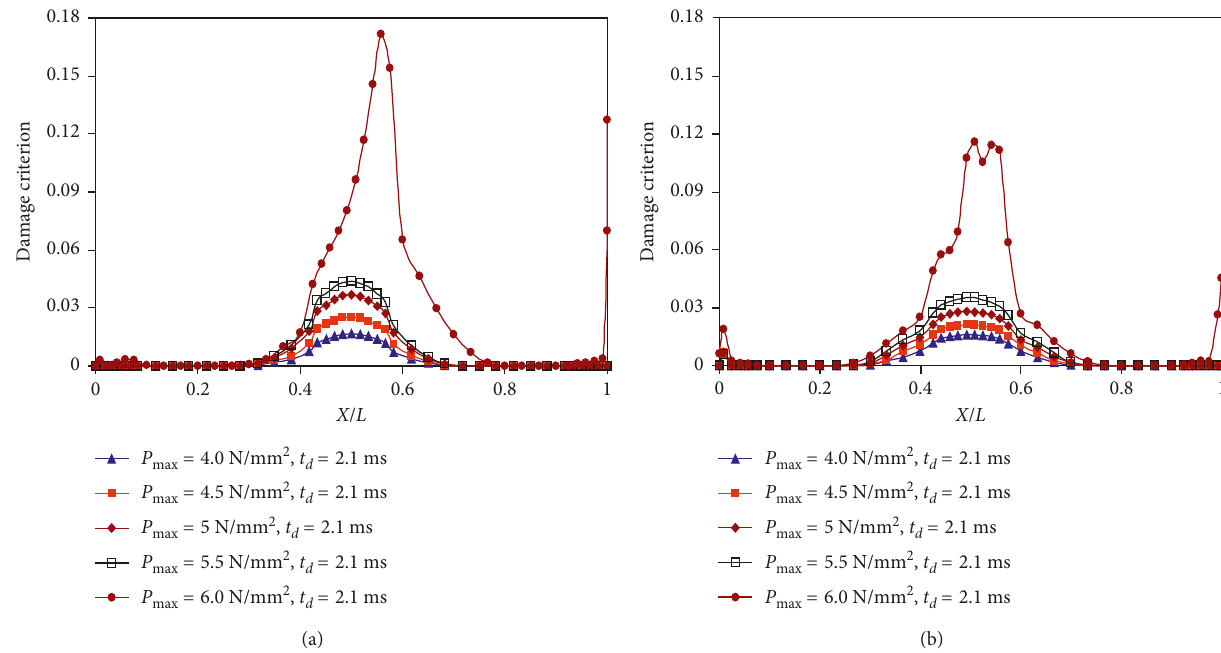
Figure 8: Damage initiation criterion profile along the steel column W150 middle of the tension flange; (b) at the middle of the web.